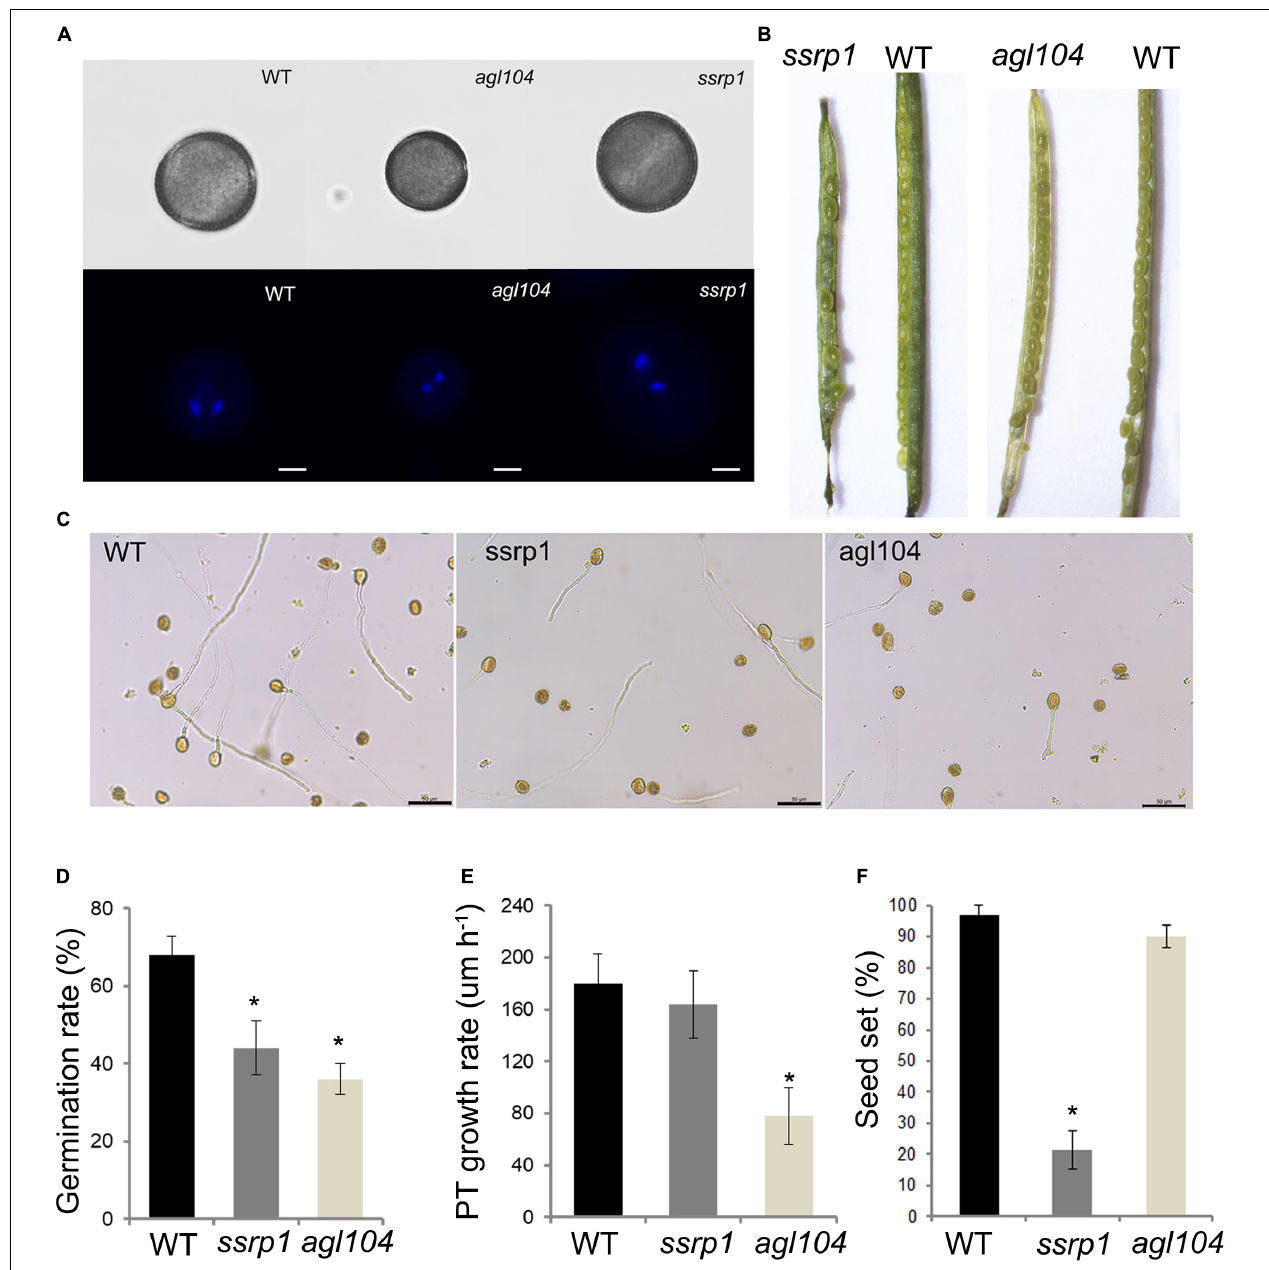
FIGURE 6 | Phenotypic characterizations of the homologous gene mutants in Arabidopsis. (A) Fluorescent microscopy of the pollens stained with DAPI, Bars = 20 µ m. (B) The seed setting in silique shows the reduced seeds of ssrp1 mutant. (C) Pollen grains germinated in a liquid pollen growth medium for 3 h, showing the reduced pollen germination rate of ssrp1 and agl104 mutants. Bars = 50 µ m. (D) In vitro pollen germination rate assay. The results are presented as mean ± s.e. (E) Pollen tube growth rate assay. The difference in length between the two-time points was divided by the time duration to yield the average pollen tube growth rate (expressed in µ m h - 1 ). The results are presented as mean ± s.e. (F) The seed setting assay. The results are presented as mean ± s.e.; * statistically significant differences with p < 0.05 by Student’s t